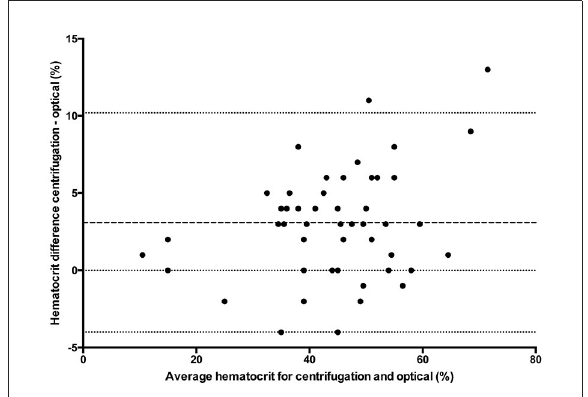
FIGURE1 Comparison of mean bias (bolder dotted line) and 95% limit of agreement (outer dotted lines) between the centrifuged hematocrit value and conductivity method.